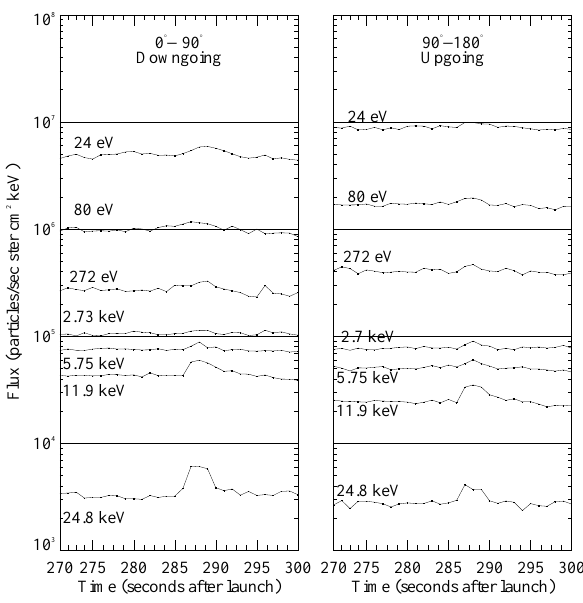
Fig. 6. Flux for the pulsation observed at 285s after launch for selected energies at 0 ◦ –90 ◦ and 90 ◦ –180 ◦ pitch-angle